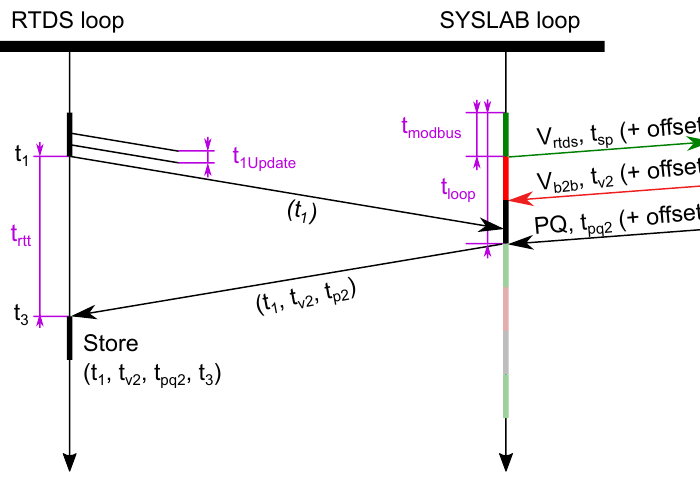
Figure 6. Time exchange protocol and associated